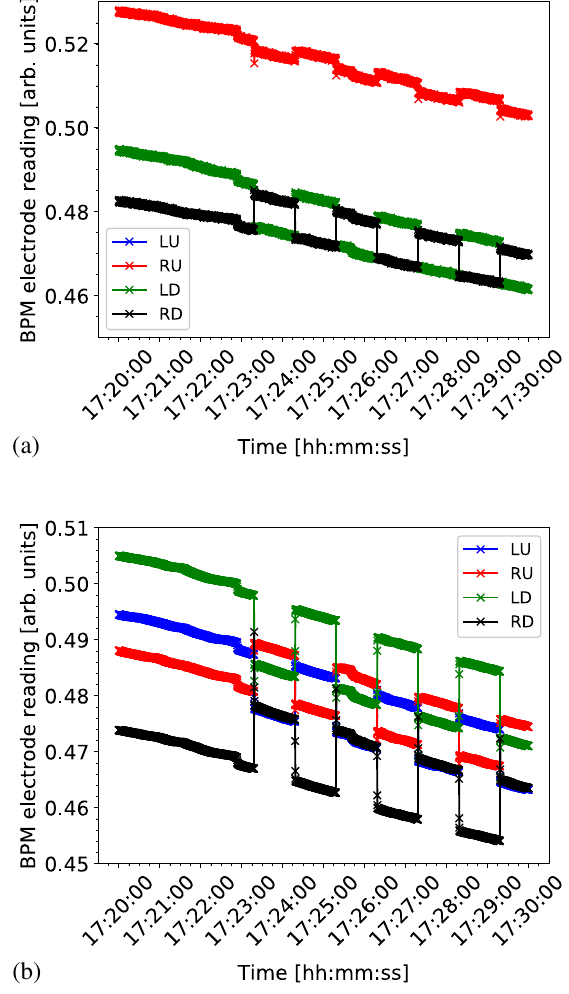
FIG. 8. The BPM pick-up signals during the electronics calibration test, during which the BPM channels are inverted seven times. The slight decrease in the signal amplitudes over time is due to the intensity decrease from normal beam